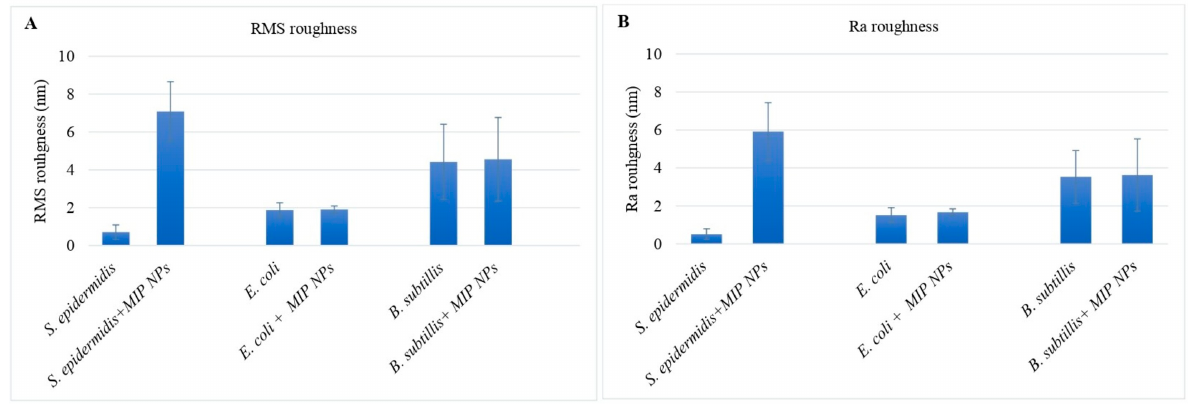
Figure 7. Surface roughness changes of S. epidermidis, E. coli, and B. subtilis after incubating with MIP nanoparticles. ( A ): RMS roughness; ( B ): Ra roughness.